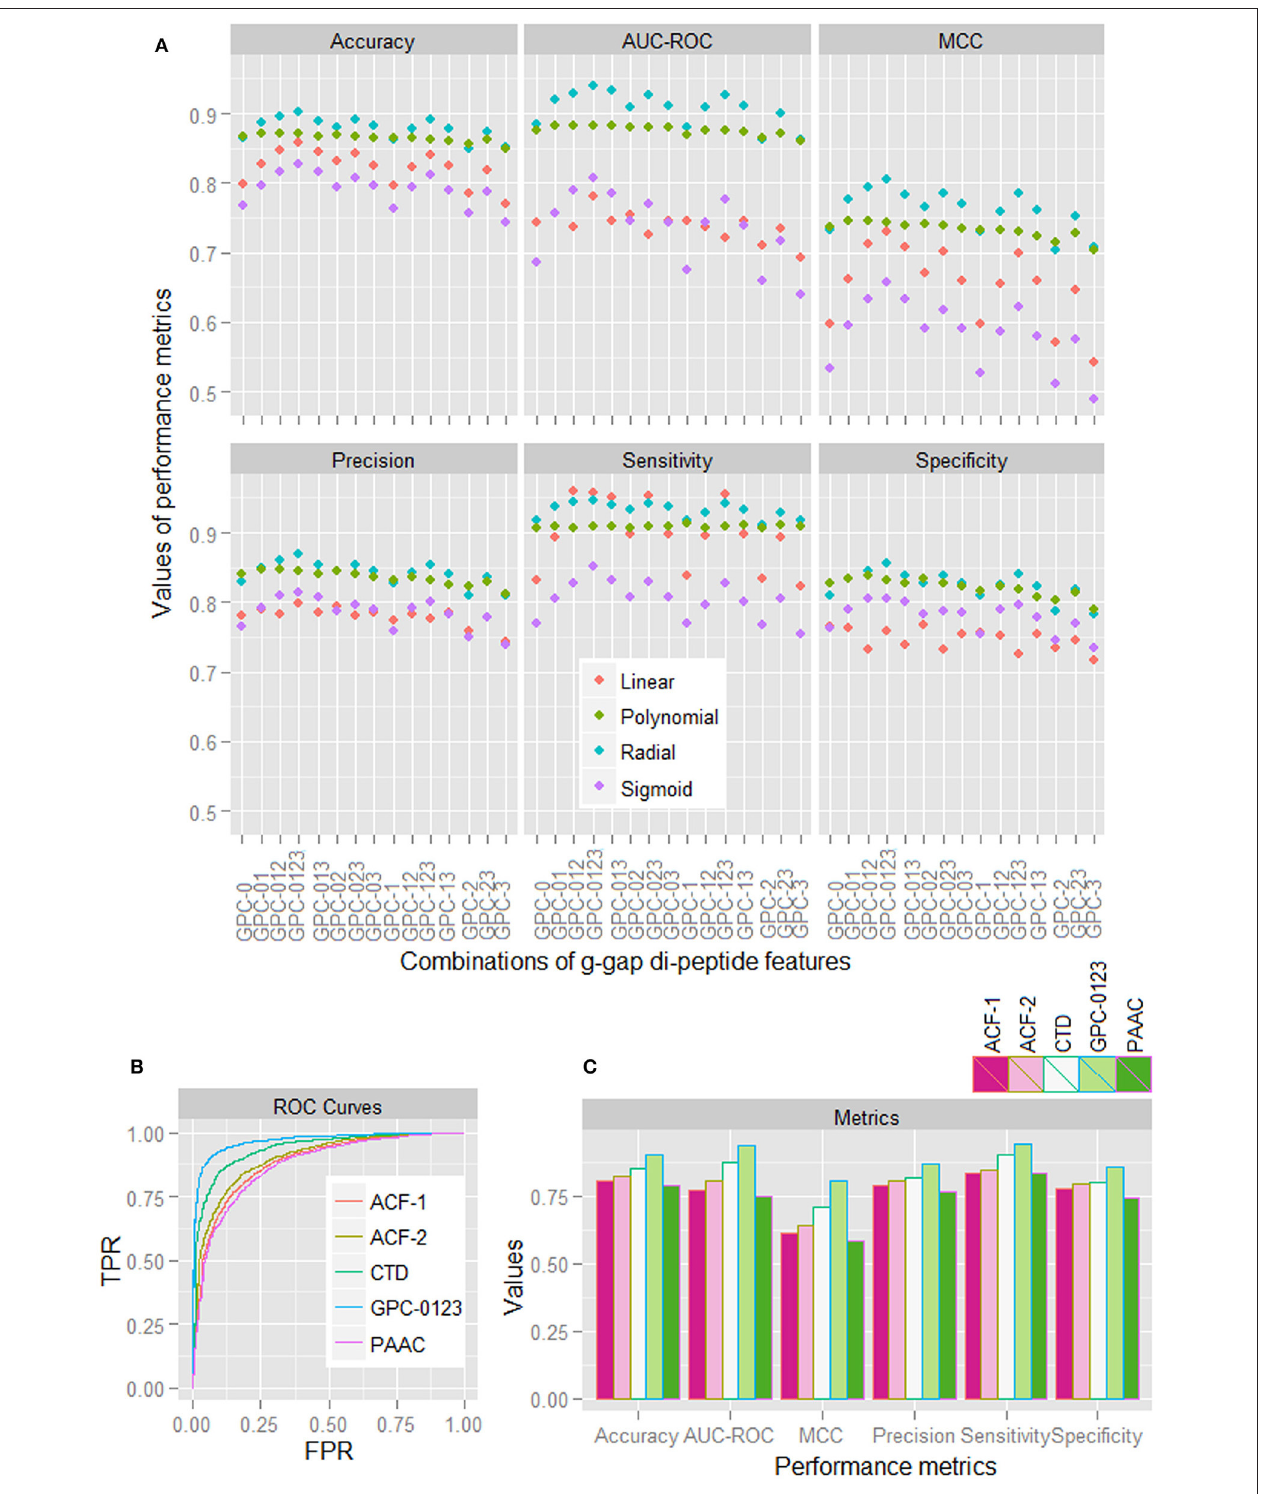
FIGURE 1 | (A) Performance metrics of SVM for four different kernels, under different combinations of 0-, 1-, 2-, and 3-spaced base pair features. (B) ROC curves for SVM with RBF kernel, under different feature sets i.e., ACF-1, ACF-2, CTD, GPC-0123, and PAAC. (C) Values of different performance metrics for SVM with RBF kernel under different feature sets. It can be seen that the values of performance metrics for SVM with RBF kernel under GPC-0123 feature set are higher than that of other feature sets.